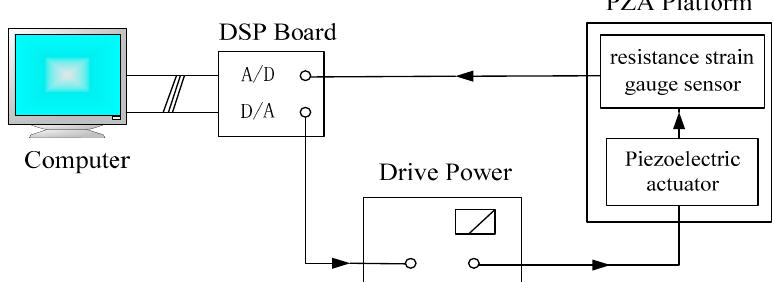
Figure 1. The piezoelectric actuator-based experimental system.